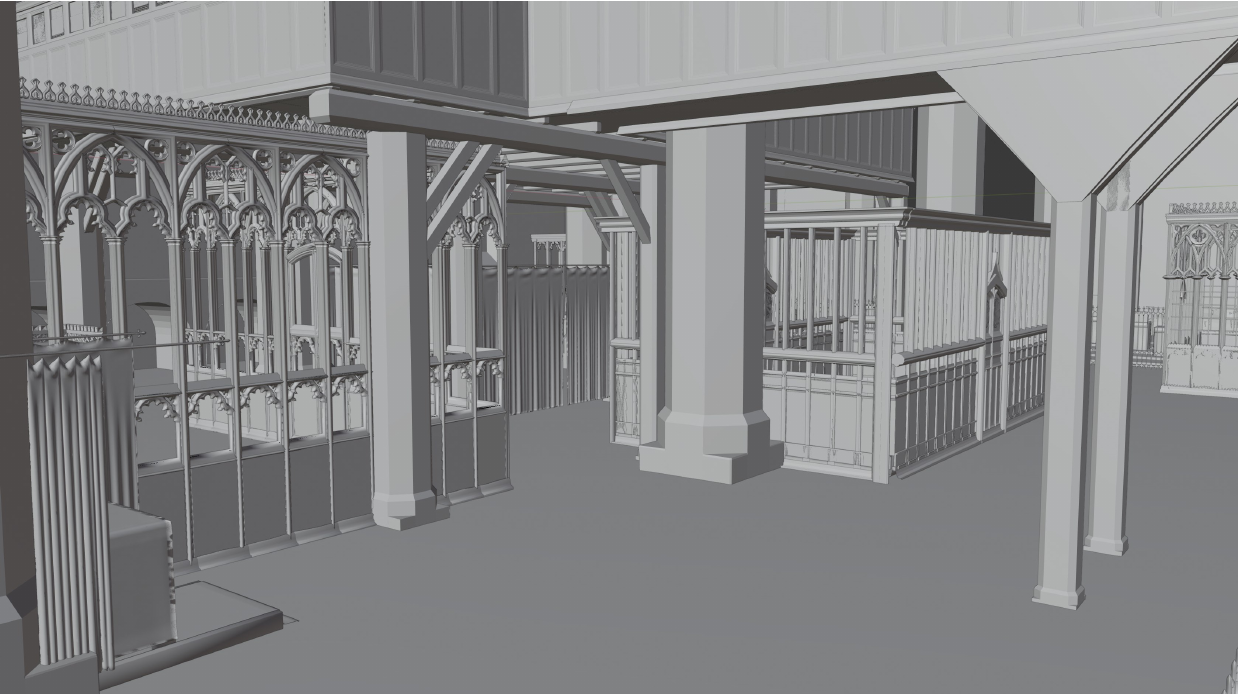
Figure 3. 3D model of three reconstructed chapels (left foreground, middle, right background). In the far left corner is the side of an altar with textile curtains, and a platform on its front covered by a carpet. View from the northeastern side of the nuns’ gallery (compare with Figure 4) towards